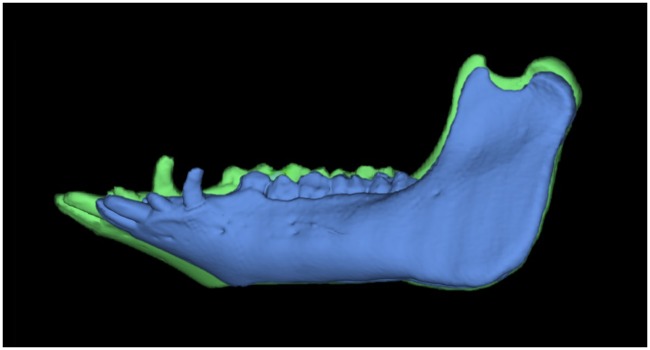
Lateral view of the same segmented mandible showing growth changes.The segmentations show the mandibular volume at 17 (blue) and 21 (green) months of age, merged and presented at the same scale.